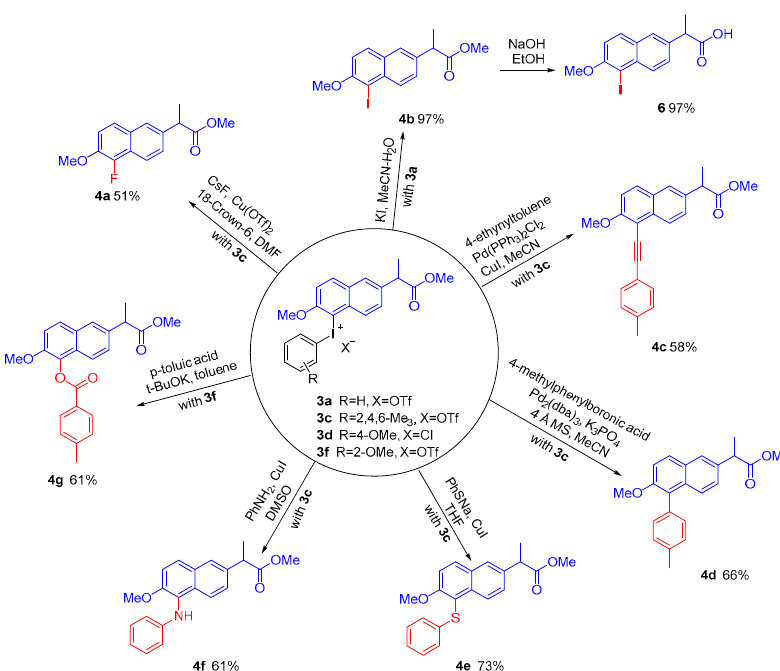
Figure 3. The modification of the aromatic ring of naproxen methyl ester from iodonium salts 3 .